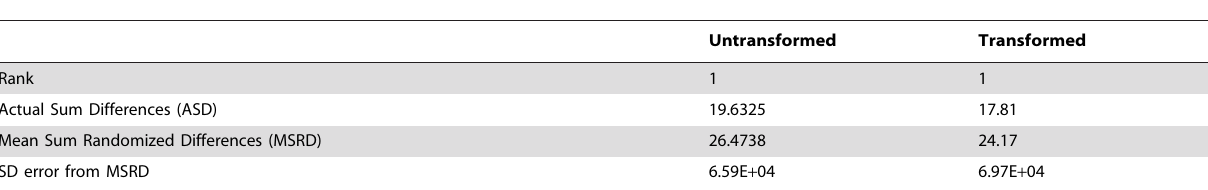
Table 3. Factorial randomization of the hypothesis